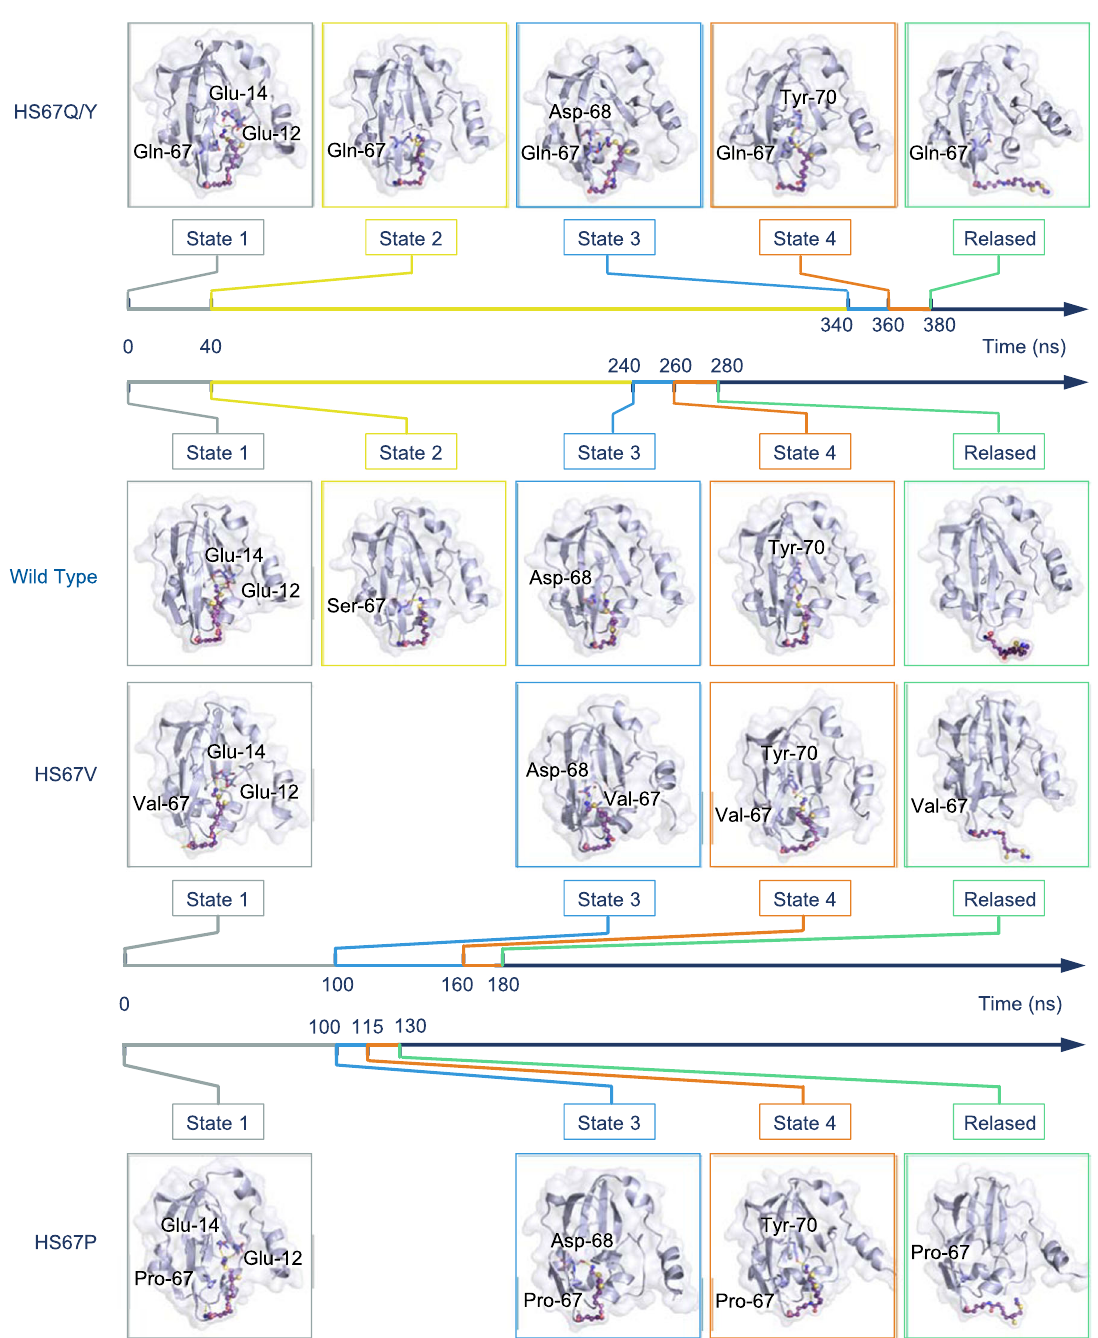
Fig. 7 Different states and the time spans in the different steps of the mutants in comparison with those of the wild-type protein H. The time spans (in ns) in the different states of the mutants HS67Q/Y and HS67V are given below the corresponding panels with the MD graphs. Those for the wild type and the mutant HH67P are given above the corresponding